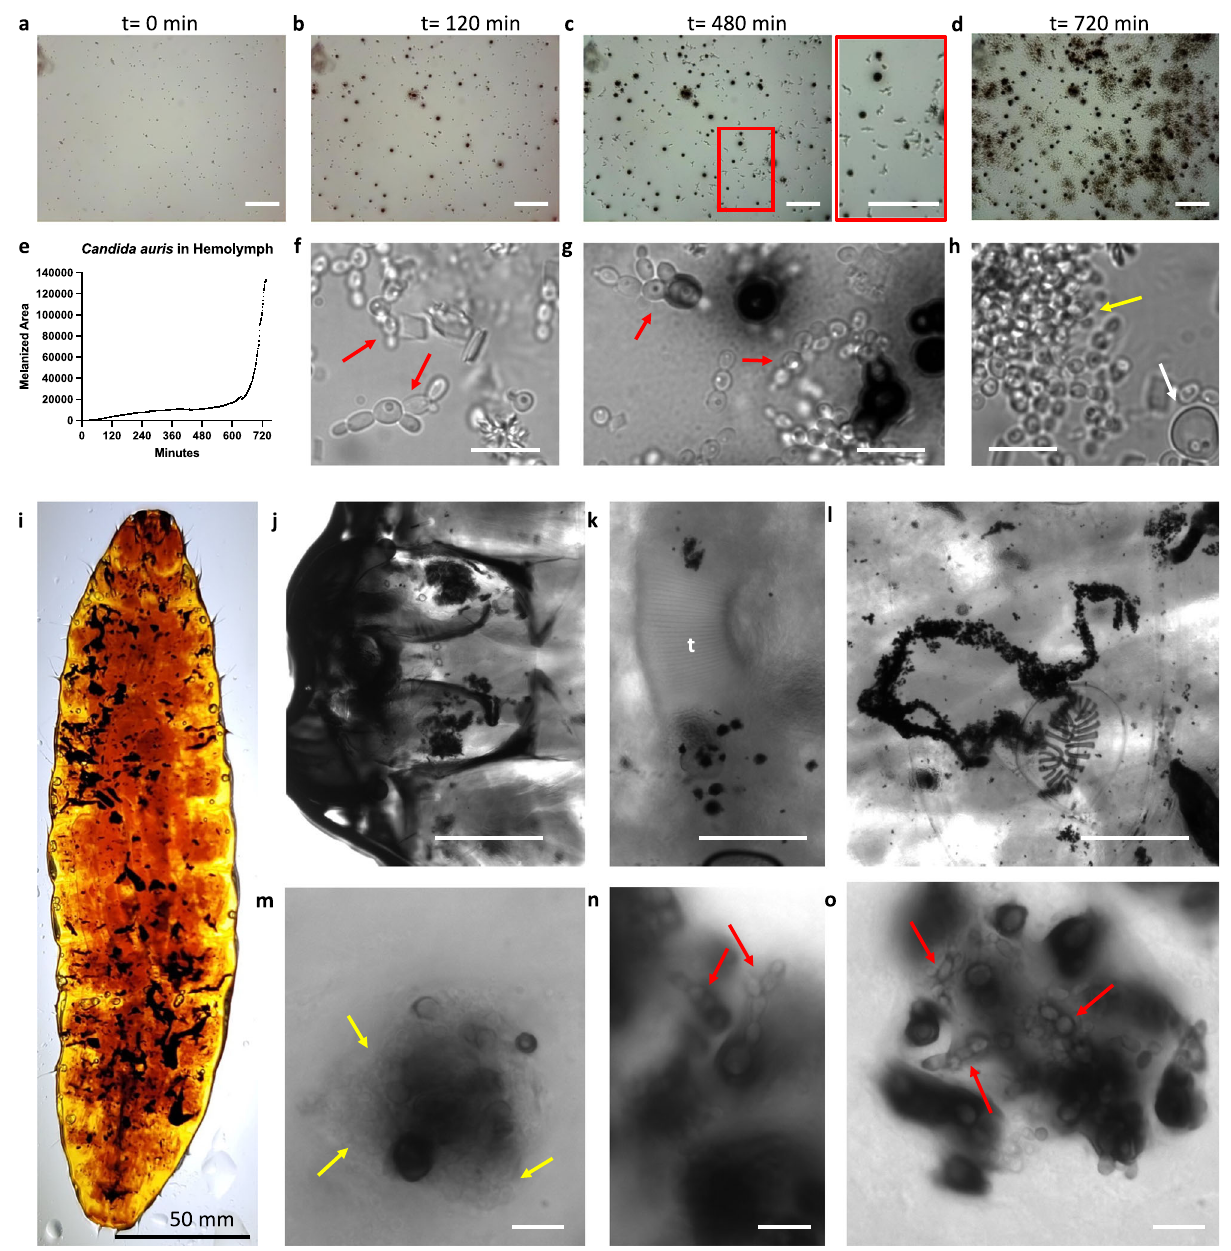
Fig. 6 Candida auris produces pseudohypae in response to hemolymph. Following incubation of C. auris with hemolymph, the yeast get encapsulated with melanin by 120 min ( a , b ). Pseudohyphae form clearly by 480 min, while not eliciting a melanization response ( c , inset); however, after ~720min, there is a sharp increase in melanization within the hemolymph ( d ). A representative graph of the melanization in response to C. auris over time is shown in e . The cell morphologies were con fi rmed as pseudohyphae through light microscopy at ×100 magni fi cation (e.g., red arrows), while the presence of enlarged giant cells was occasionally noted ( h , white arrows) and dense clusters of yeast ( h , yellow arrows). i Melanized aggregates of C. auris can be seen in G. mellonella larvae following tissue clearing. Melanized clusters of fungi can be seen in the head capsule ( j ), associated with trachea ( k , t label) and freely within the tissue ( l ). In these melanized areas, we can see aggregates of yeast ( m , yellow arrows) and pseudohyphae ( n , o , red arrows). All panels are representative images and data from three independent replicates. Scale bars in panel i represent 50 mm, j – l represent 500 µ m, a – d represent 100 µ m, while f – h , m – o represent 10 µ